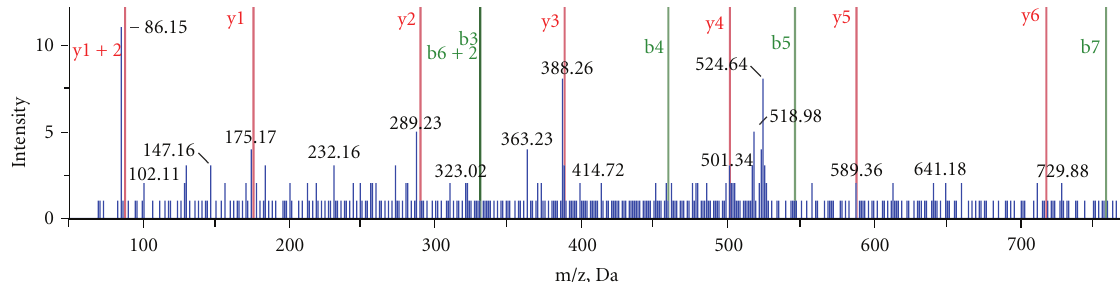
Figure 3: Zinc finger protein 350 spectra: Zinc finger protein 350 was identified in endothelial cells of estrogen receptor negative and not in estrogen receptor-positive breast tissue. LC-Q-TOF MS/MS spectra of LQSESLVNR peptide generated from the trypsin digestion of ZNF